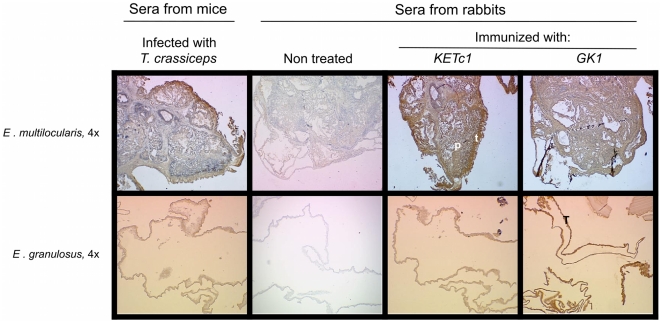
Immunolocalization of the S3Pvac peptides in E. granulosus and E. multilocularis.Sections of larval specimens reveal a strong binding to the tegument (T) as well as in the parenchyma (P) of E. multilocularis and in tegument of E. granulosus. (A) Control labeled with rabbit pre immune serum. (B) Positive control labeled with polyclonal sera from rabbit immunized with a total extract of Taenia crassiceps ORF cysticerci.